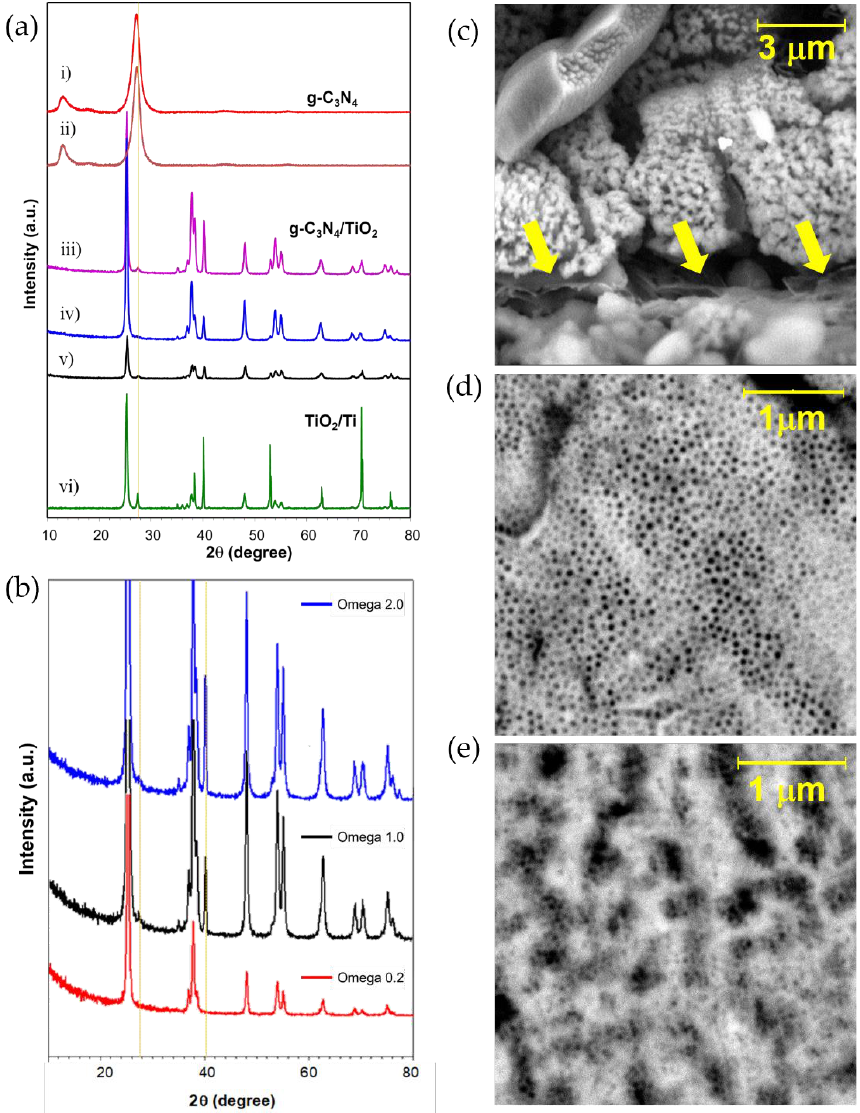
Figure 2. ( a ) XRD profiles. (i) and (ii) g-C 3 N 4 powders from MU 24 and M 24 precursors recovered in